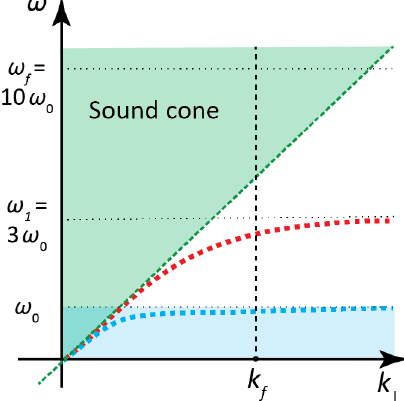
FIG. 6. Subwavelength imaging principles. Dispersion rela- tions of locally resonant media composed of densely packed subwavelength resonators with different resonance frequencies ω ω ¼ 3 ω 0 (blue dashed line) and 1 0 (red dashed line). Both lines lie below the sound cone (semitransparent green region). Only the first resonant medium possesses modes with high transverse wave-vector components k ⊥ up to k f below ω 0 , i.e., in the subwavelength